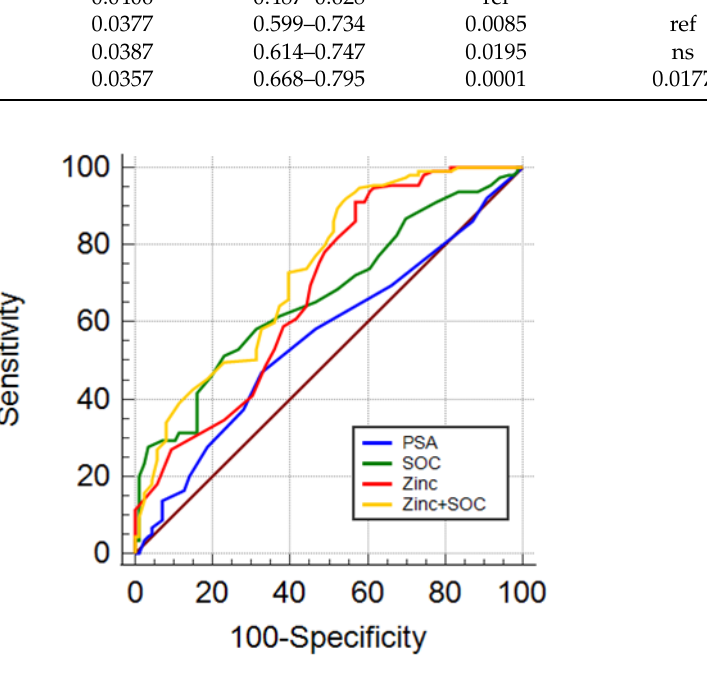
Figure 4. Diagnostic performance in detecting csPCa: AUC ROC for standard parameters PSA (blue line), SOC (PSA, age, DRE, green line), Zinc (red line), combination of zinc and SOC (zinc + SOC, yellow line).